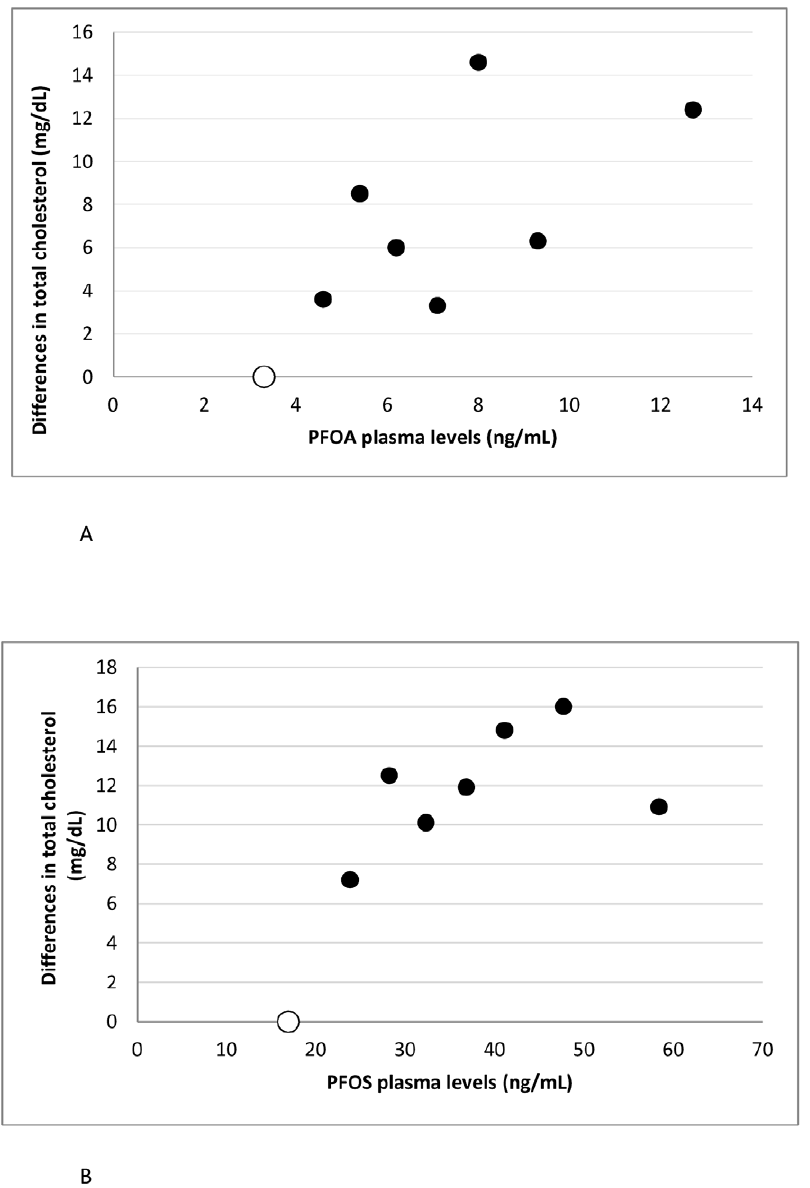
Figure 2. Associations between plasma PFOA and PFOS levels and total cholesterol. The Figure illustrates differences in total cholesterol levels according to eight exposure groups of (A) PFOA and (B) PFOS. The lowest exposure groups are used as reference (open dots). The dots are placed at the median of the eight exposure categories. Models are adjusted (sex, age, years of school attendance, body mass index, smoking status, alcohol intake, egg intake, animal fat intake and physical